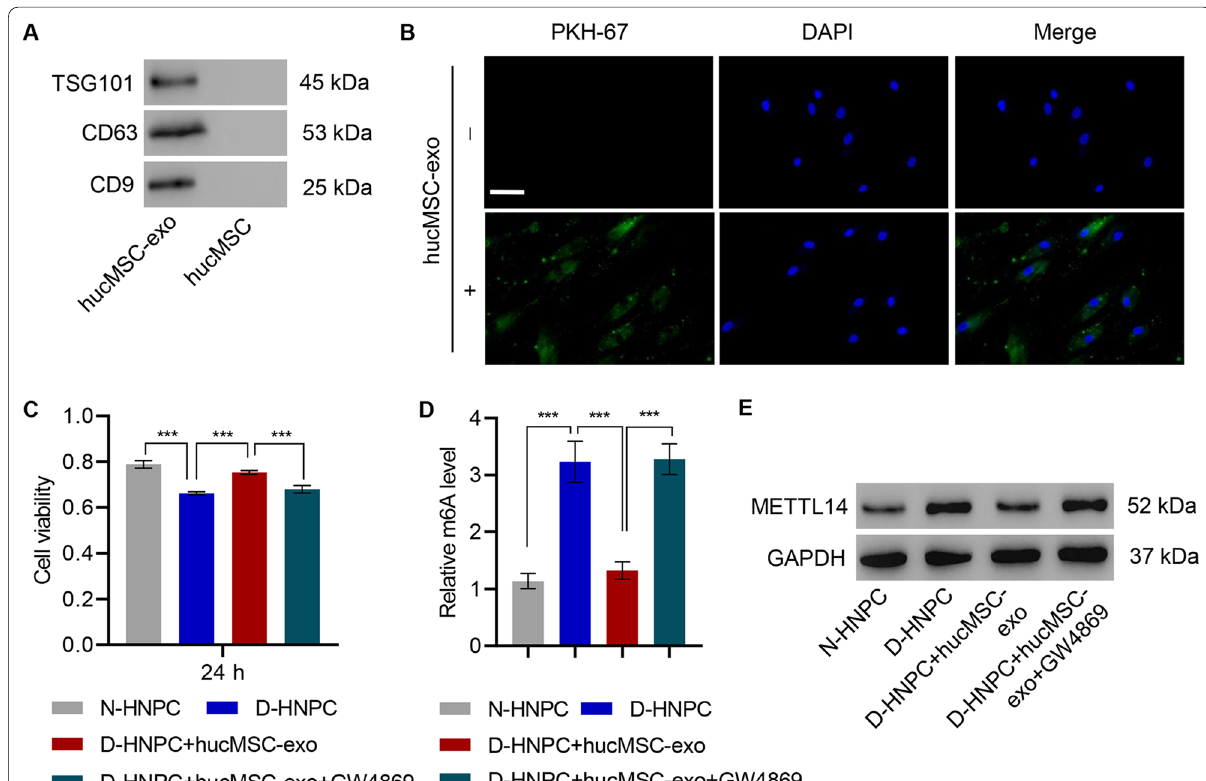
Fig. 2 HucMSC-derived exosomes were successfully produced and endocytosed by HNPC. A Exosome markers CD63, CD9, and TSG101 proteins were detected by western blot in hucMSC-exo and hucMSC. B Internalization of exosomes by D-HNPC examined by laser scanning confocal microscope. Scale bar : 50 μm. Effect of hucMSC-exo depleted of exosomes on C cell viability, D m 6 A level, and E METTL14 expression in HNPC with or without 20 μM GW4869. *** P <